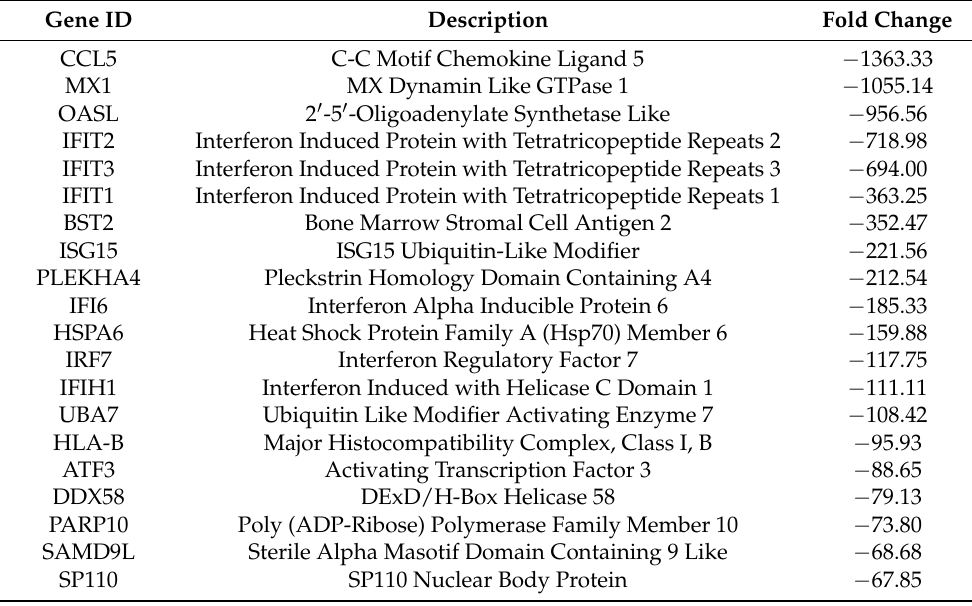
Table 1. List of top 20 downregulated differentially expressed genes ( p -value ≤